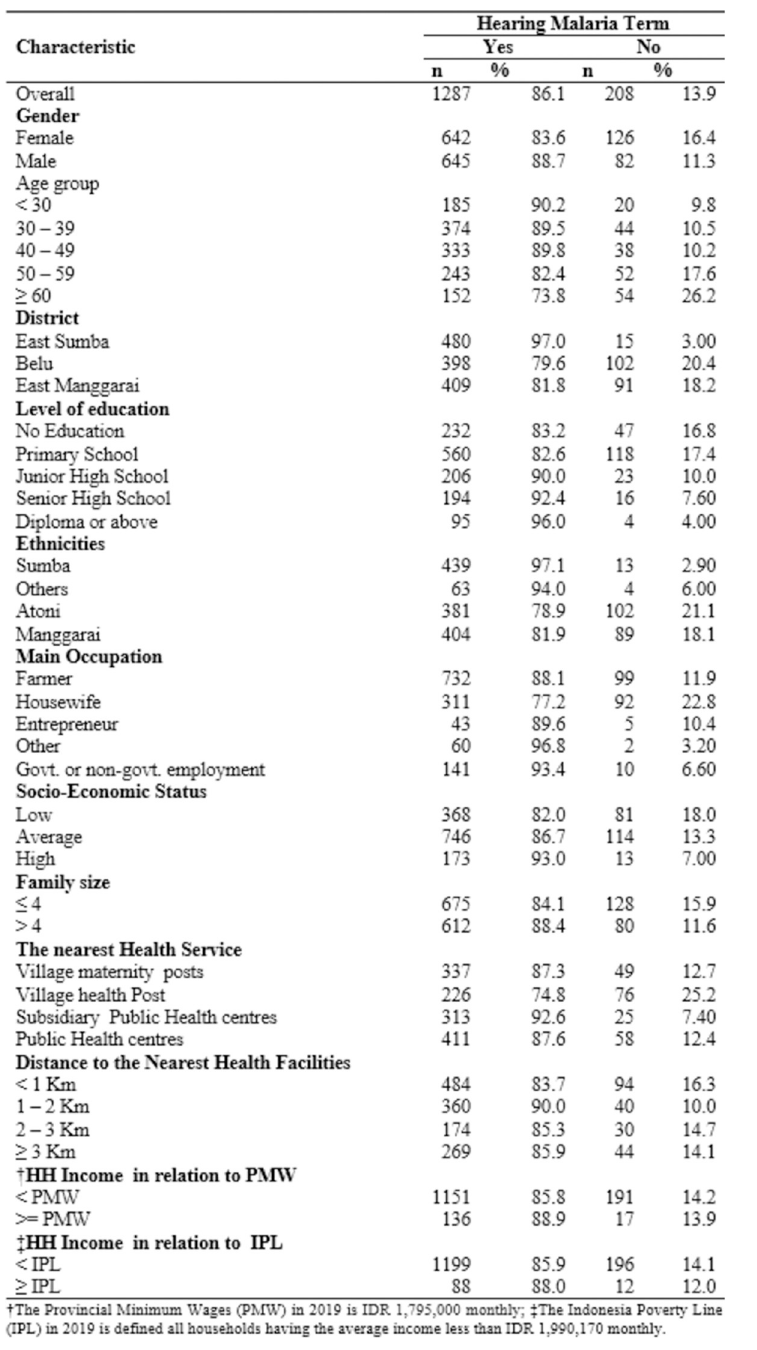
Fig 1. Awareness of malaria and its association with the sociodemographic and environmental characteristics of respondents in the East Nusa Tenggara Province, Indonesia (n = 1495).